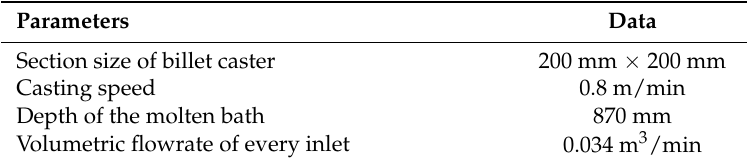
Table 2. Operating parameters of the prototype tundish.